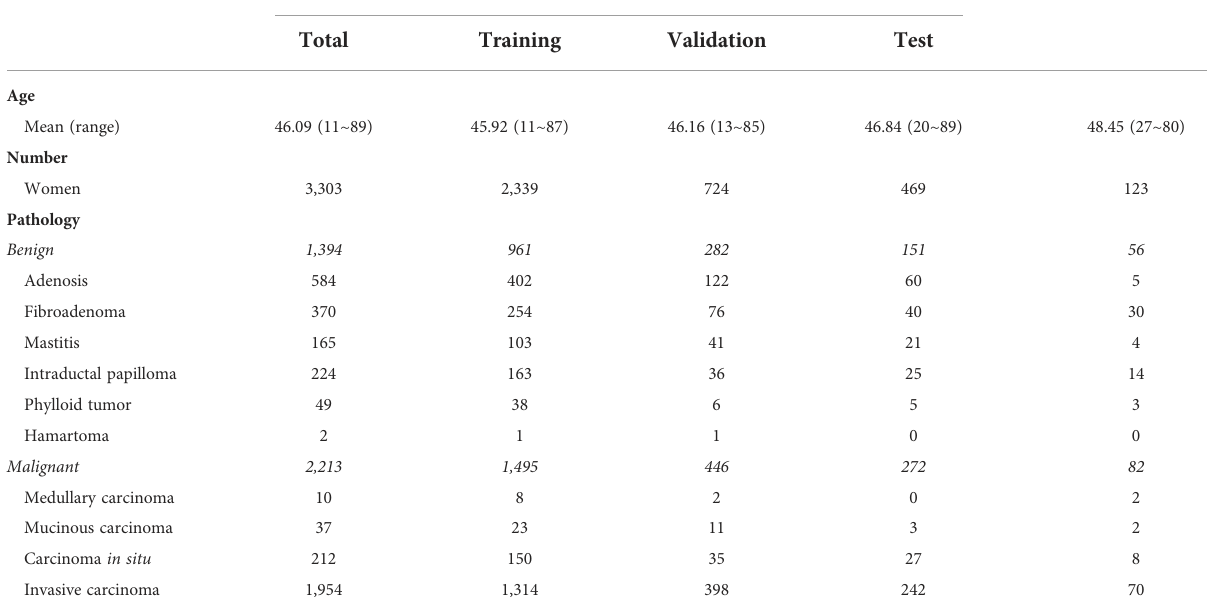
TABLE 1 The characteristics and pathological types of patients included in the